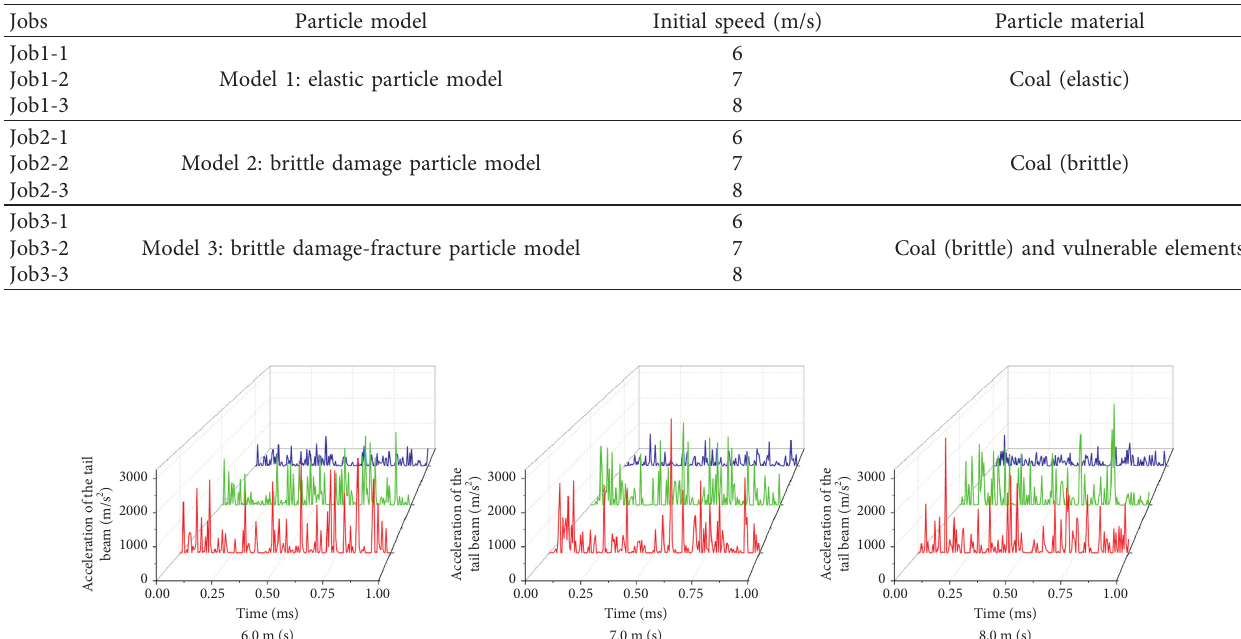
Table 3: Settings of the simulation jobs.